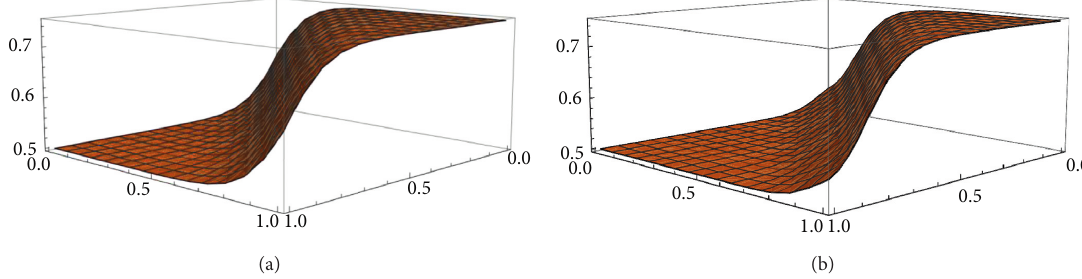
Figure 1: Distributions of approximation solutions for θ ( ρ , σ ,t ) at (a) t � 0 . 01 and (b) t � 0 . 5 with R � 100, for Example 2.